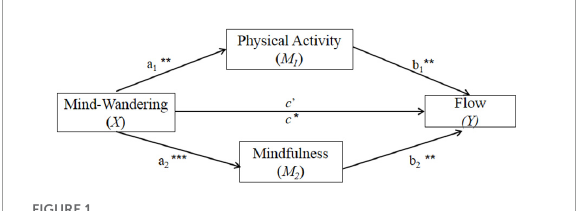
FIGURE1 Mediational model of physical activity, mindfulness on mind-wandering and flow. * p < 0.05; ** p < 0.01; *** p < 0.001.